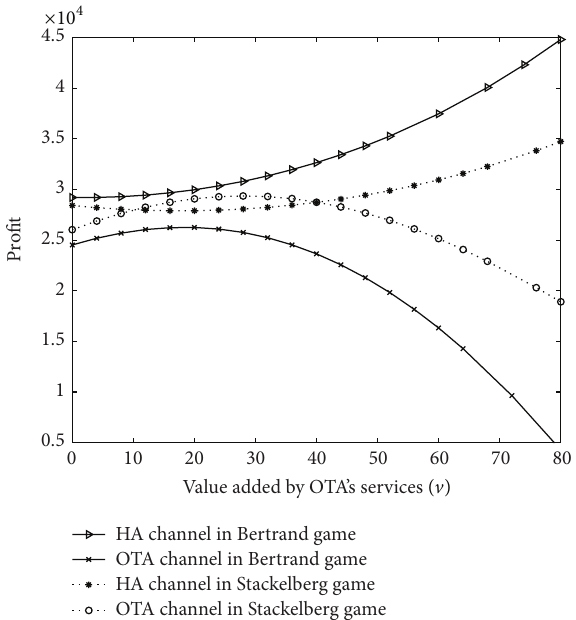
Figure 7: Channel profits in two